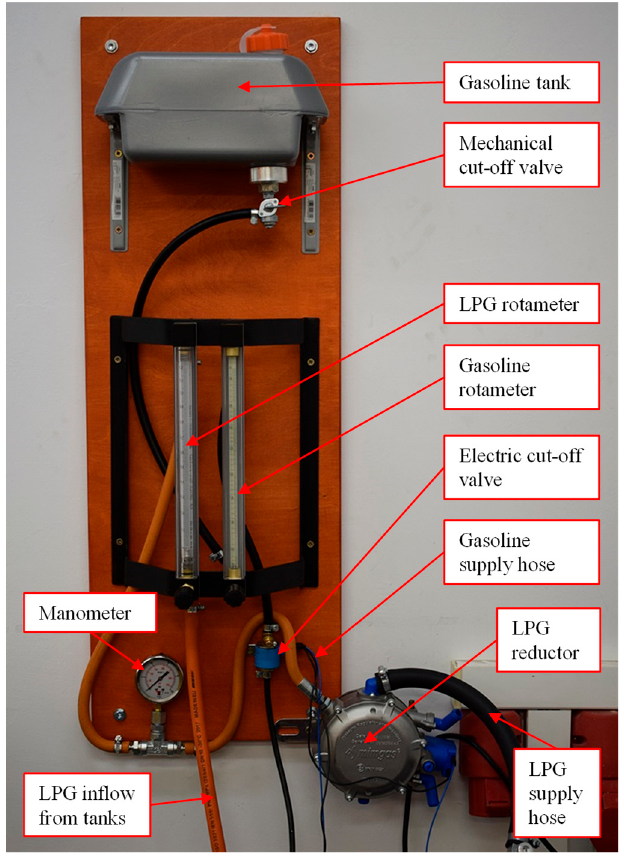
Figure 4. Laboratory test stand: dual-fuel supply system with fuel flow rate measurement section.